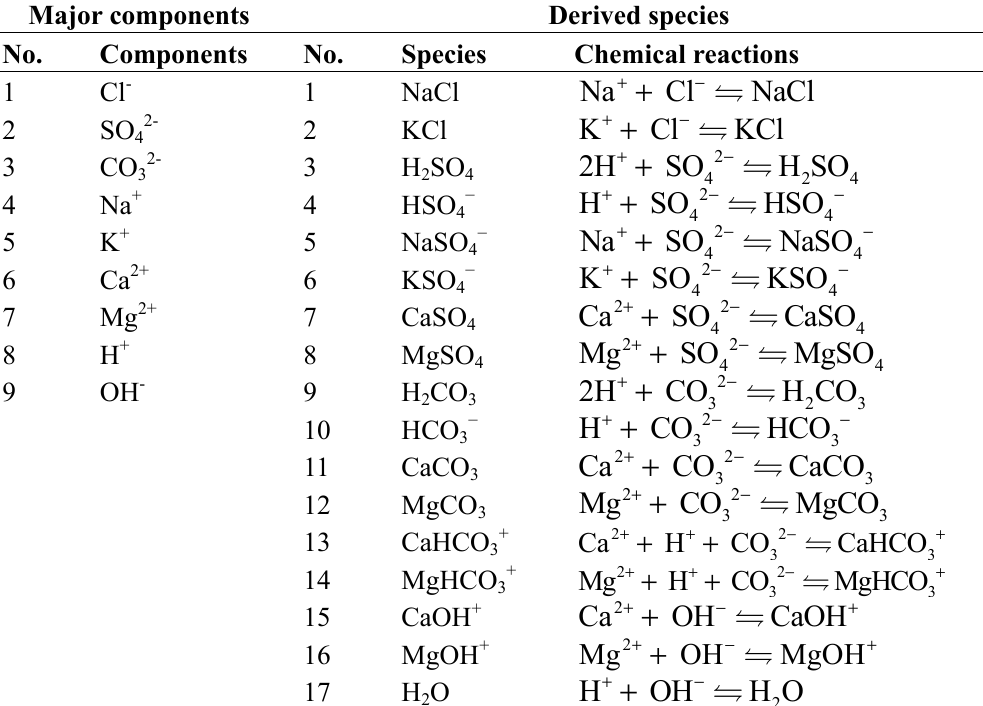
Table 2. Chemical model for the speciation calculation (9 major components and 17 derived